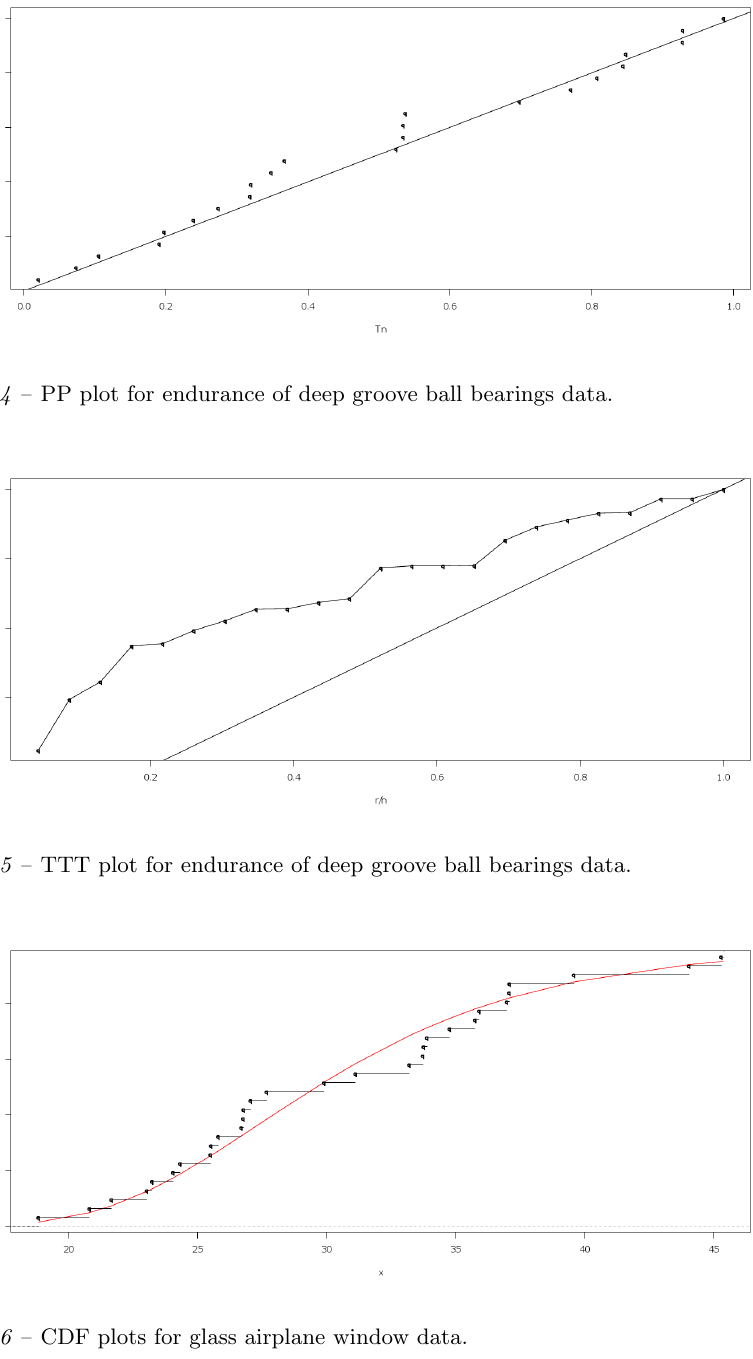
Figure 6 – CDF plots for glass airplane window